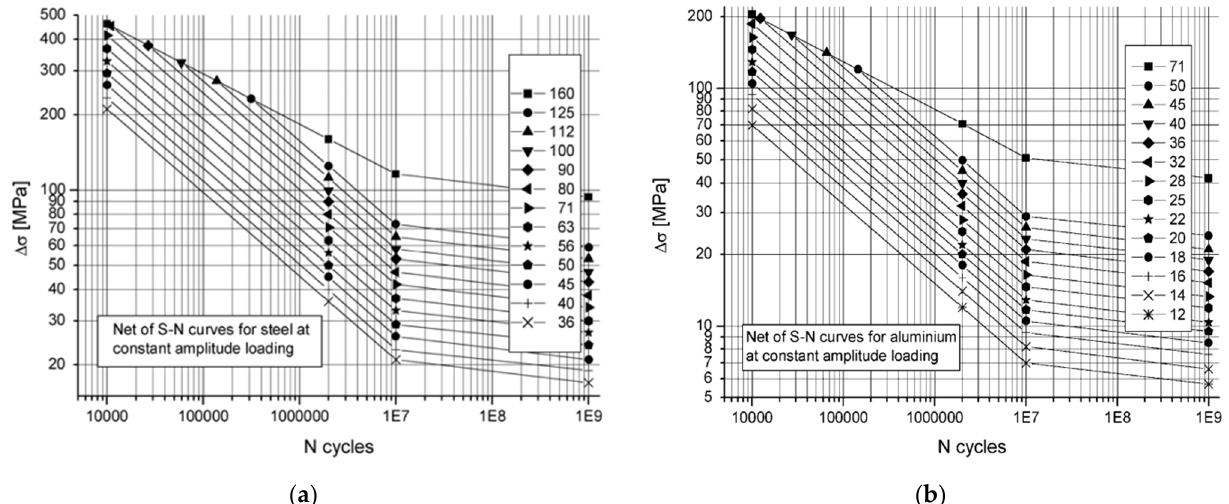
Figure 16. S–N curves applied in this study: ( a ) steel; ( b ) aluminum [20].